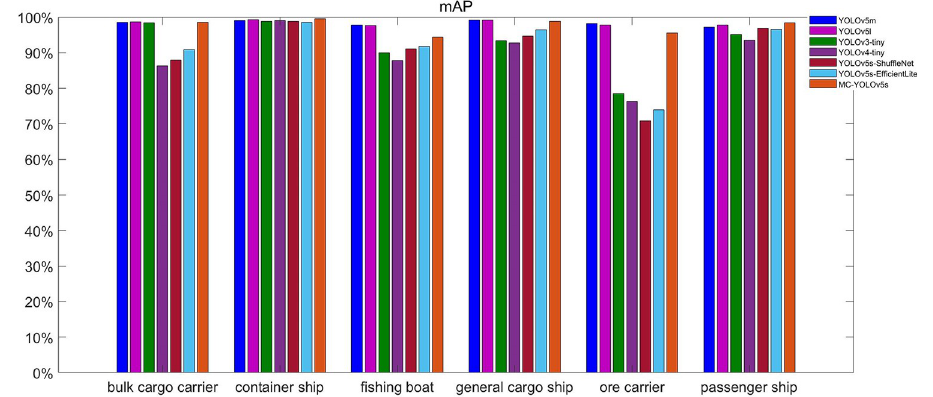
Fig 17. Inspection results of different models on different types of